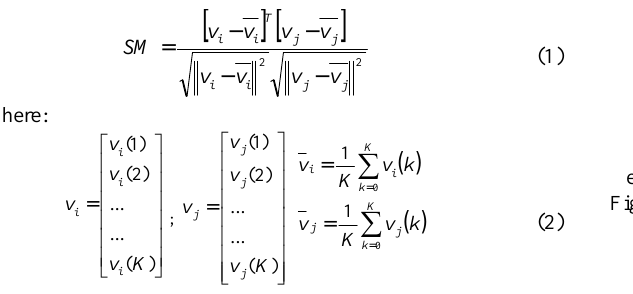
e. f. Figure 5. Example of a simple 1D regular structure with all possible pairwise transformations (a-d) which form a characteristic cumulative pattern in the transformation space